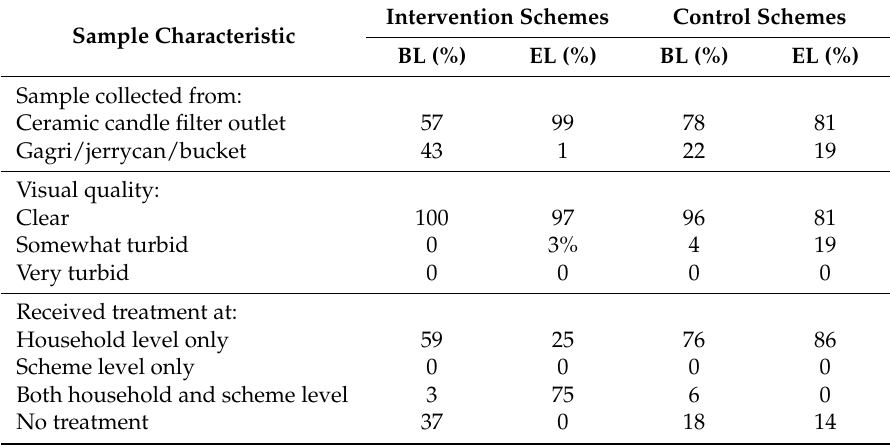
Table 4. Characteristics of stored water samples collected from